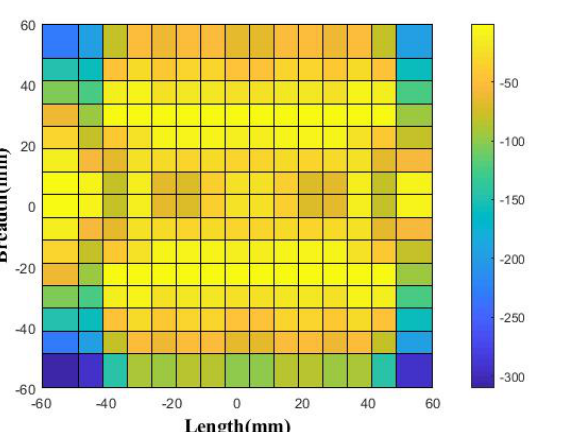
Figure 7. Phase distribution noted in 6.25 mm ( λ /4) above the top surface of the designed five- layer